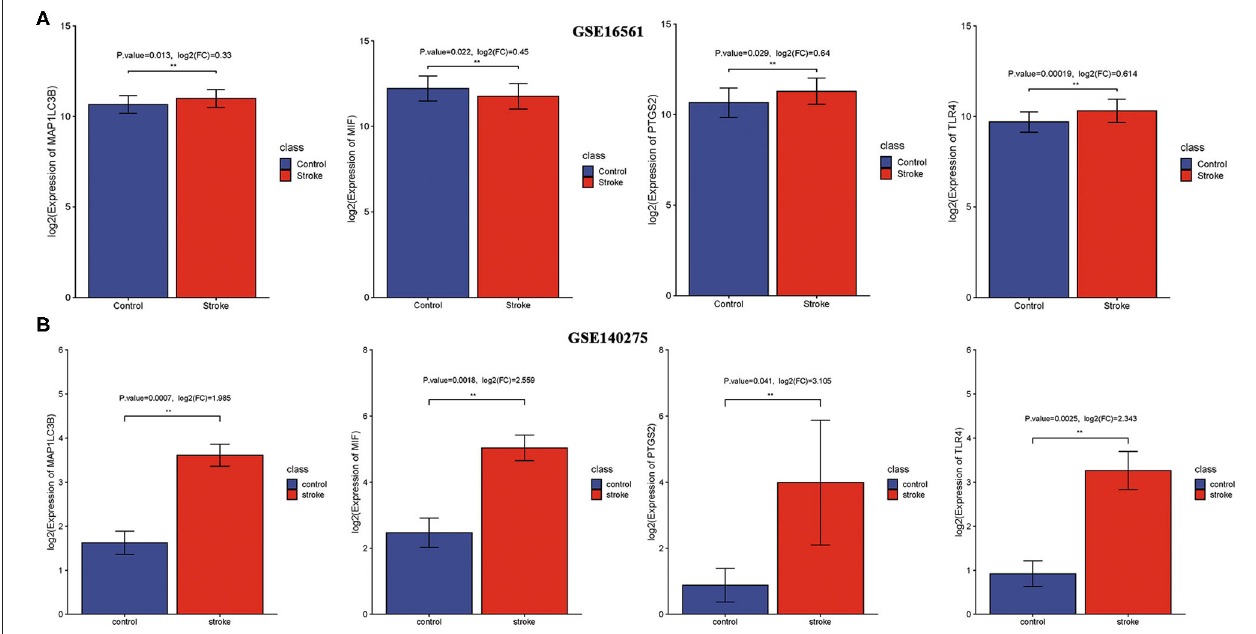
FIGURE 4 | The expression of ferroptosis-related biomarkers in ischemic stroke. (A) The expression of ferroptosis-related biomarkers in ischemic stroke vs. normal control cohort in the GSE16561 dataset. (B) The expression of ferroptosis-related biomarkers in ischemic stroke vs. normal control cohort in the GSE140275 dataset. ** p <